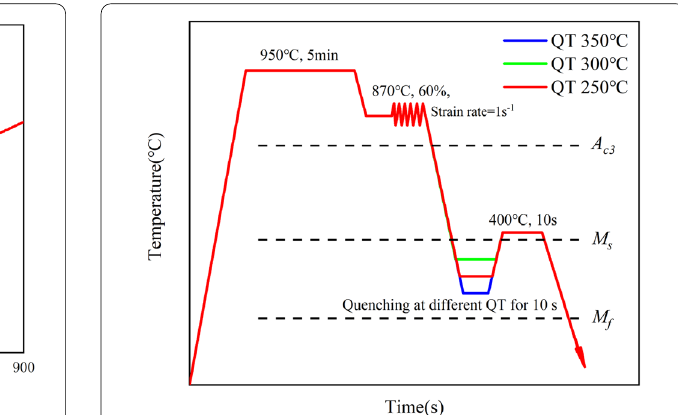
Figure 5 The second group of experiments